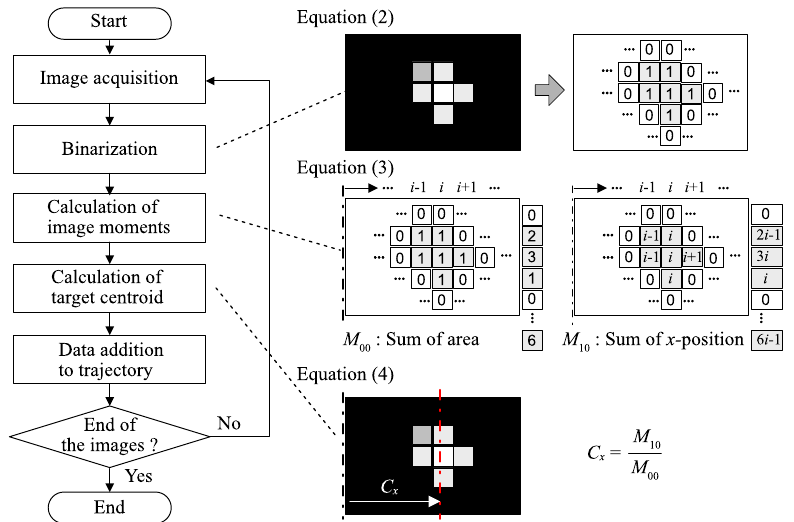
Figure 3. Flowchart for trajectory generation. The centroid of the light spot is calculated by simple image processing, such as the binarization and image moments calculation at every image frame.